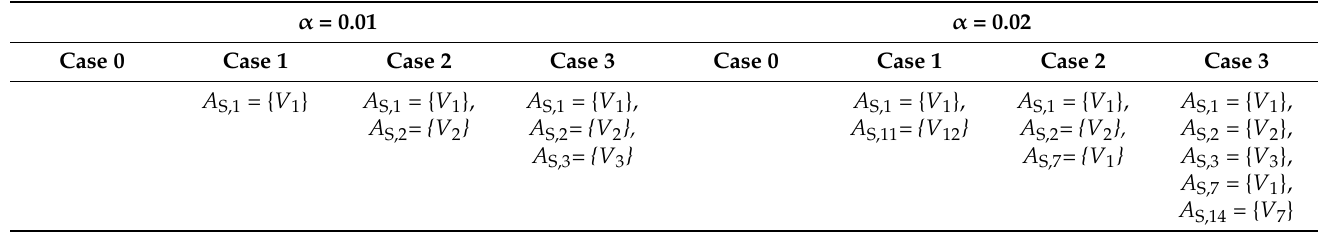
Table 19. One-Element Influence Sets for Considered Study Cases when α = 0.01, 0.02. α = 0.01 α =